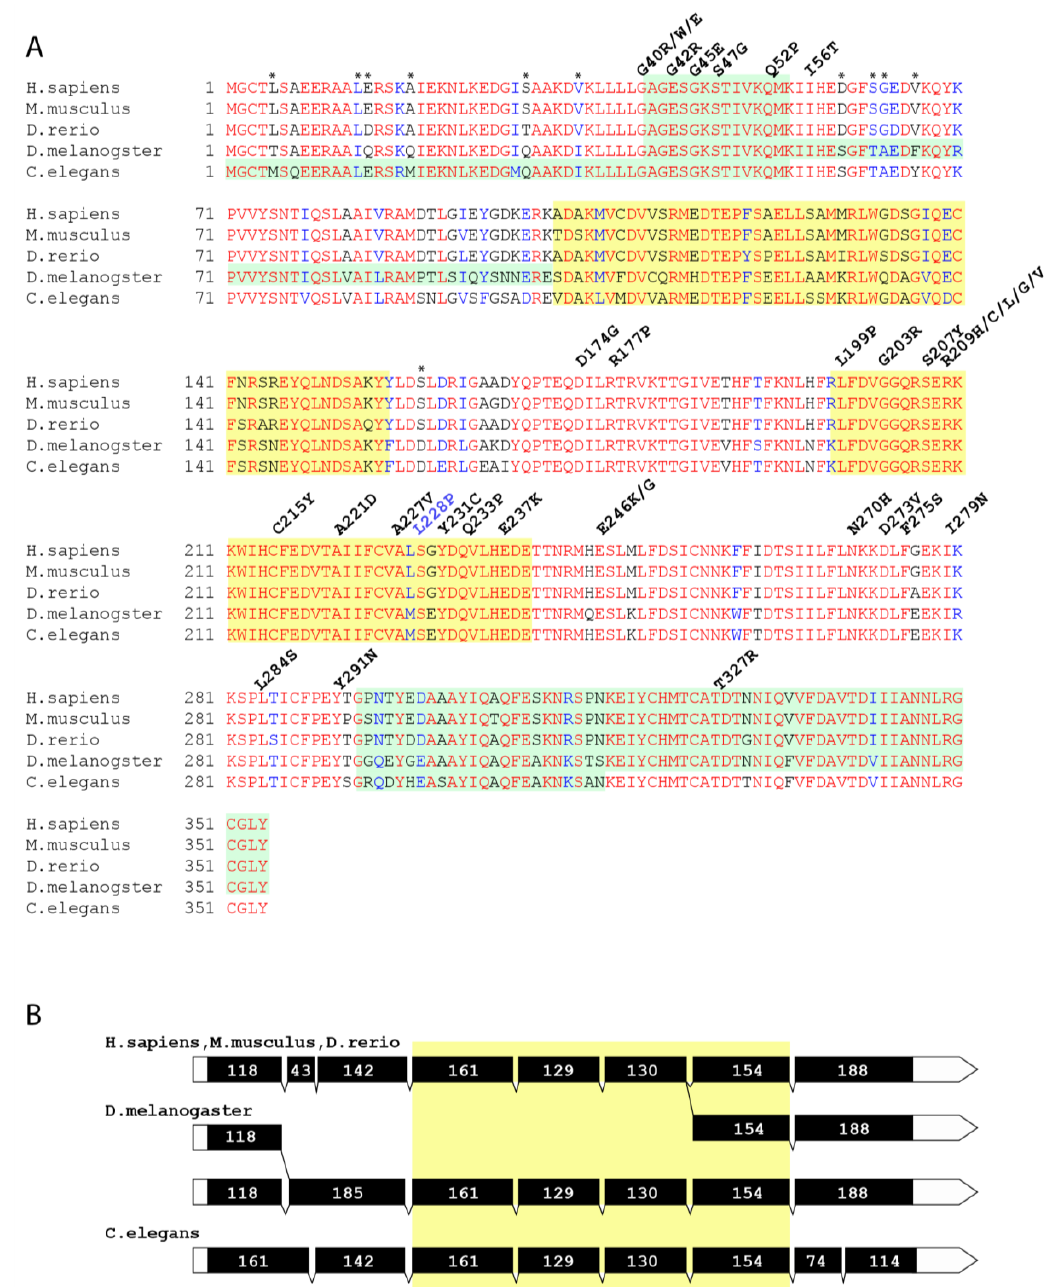
Figure 1. A . Alignment of Gαo homologs from three vertebrate and two invertebrate organisms. Pale green and yellow colours on the background of the alignment mark the exon boundaries. Above the alignment, the known mutations associated with human neurological phenotypes are designated. The mutated amino acids belong to conservative parts of proteins (letter blocks of red). The mismatching amino acids that were not replaced during the editing of d Gαo are designated with asterisks. For Drosophila , the dGαo-B isoform is shown. B . Schematic exon-intron structures of Gαo homologs. Black boxes mark the coding parts of the exons, and white boxes indicate the noncoding parts. The drawing of the exons is presented in scale. Digits inside the exons mark their precise length in base pairs. The yellow box marks identical exons in the species compared.